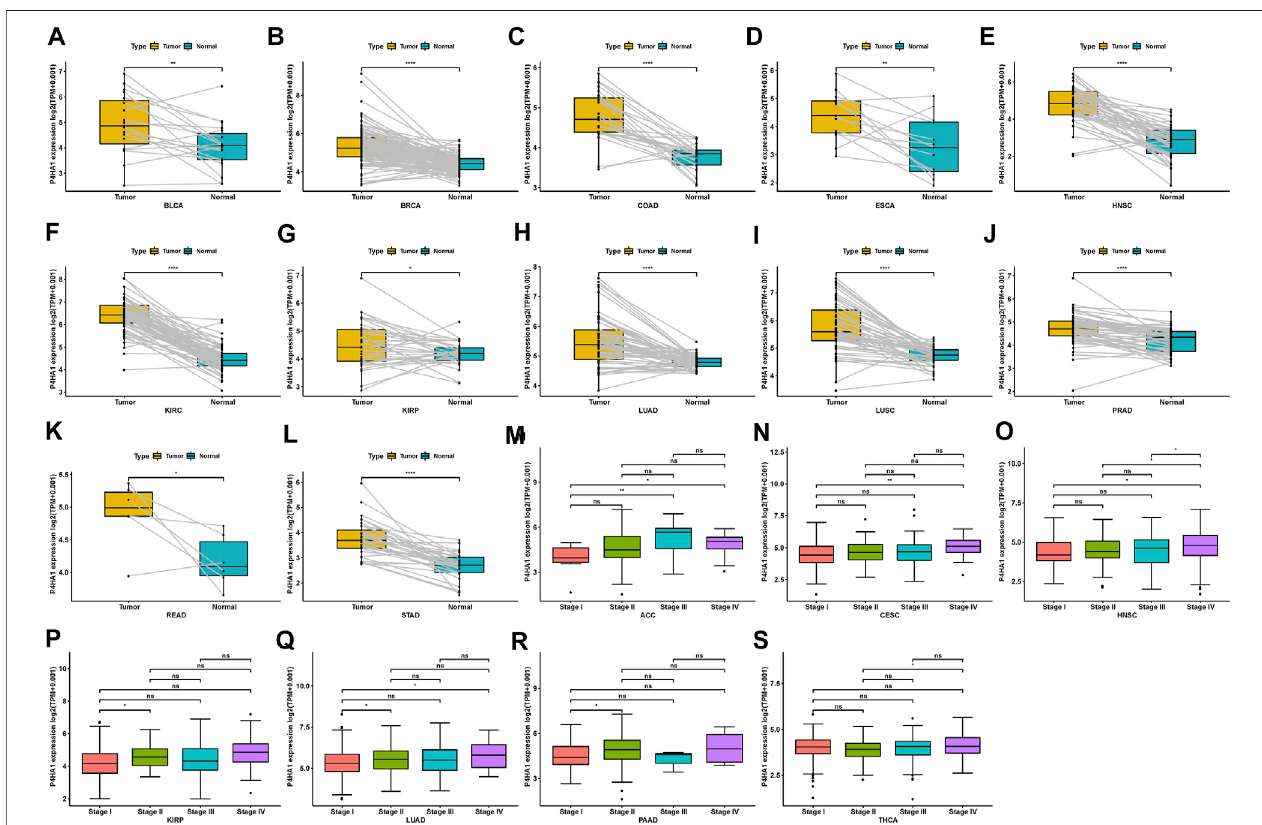
FIGURE 2 | Expression of P4HA1 in paired tumor and adjacent normal tissues and various tumor stages. (A – L) P4HA1 expression in paired tumor and adjacent normaltissuesfromTCGAinindicatedtumortypes. (M – S) P4HA1expressioninvarioustumorstagesinindicatedtumortypes.* p < 0.05,** p < 0.01,*** p < 0.001,**** p <